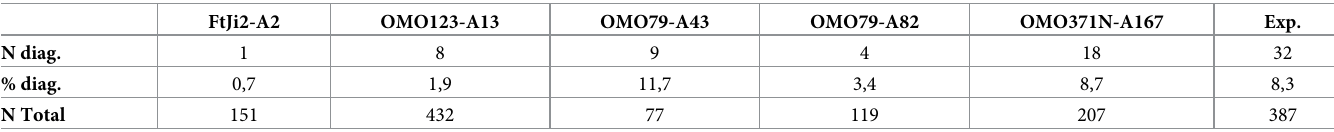
Table 3. Numbers and proportions of diagnostic bipolar flakes in the archaeological and experimental assemblages. (NB. only whole flakes and broken flakes preserv- ing both their proximal and distal extremities are considered). FtJi2-A2 OMO123-A13 OMO79-A43 OMO79-A82 OMO371N-A167 Exp. N diag. 1 8 %